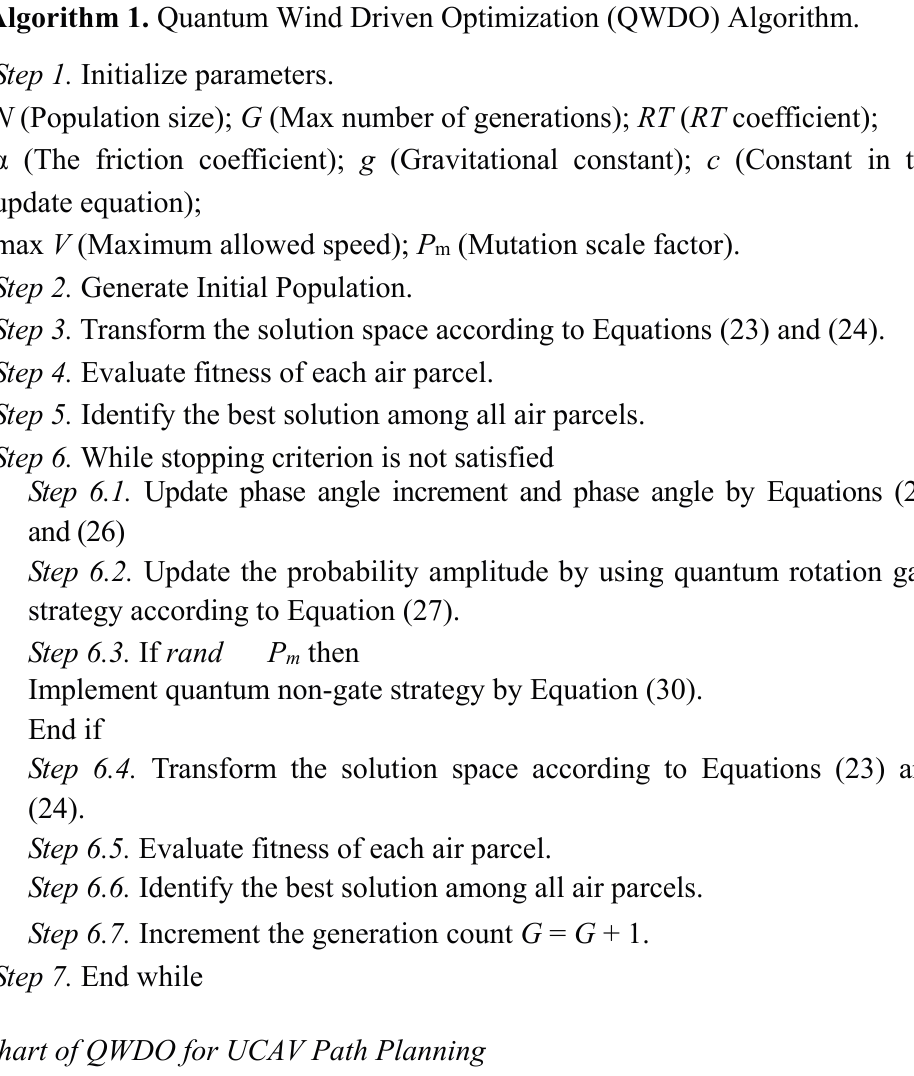
Algorithm 2. QWDO for UCAV Path Planning